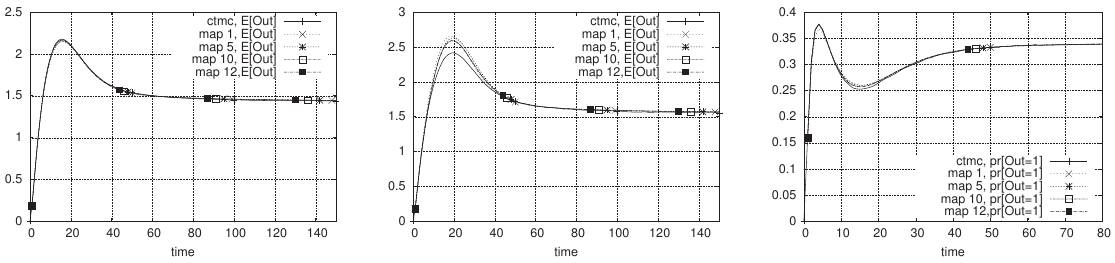
Figure 11: Expected number and variance of requests, and probability of having one request at the Out station as function of time using a model composed of load-dependent stations.